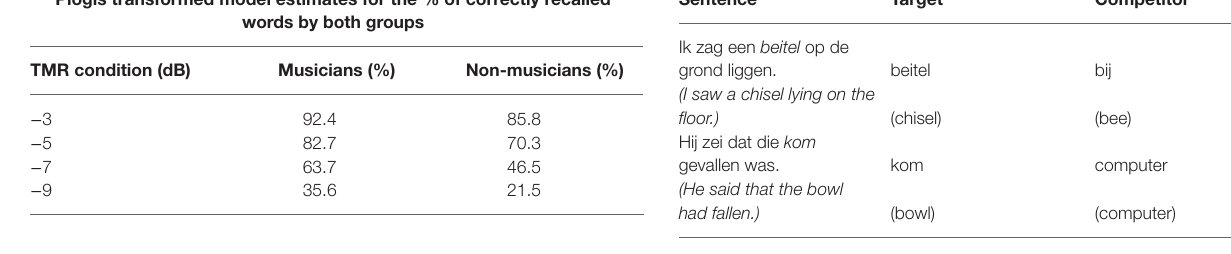
TABLE 3 | Bootstrapped estimates for the 95% confidence intervals, based on resampling of the sentence recall model. Bootstrap resampling: confidence intervals